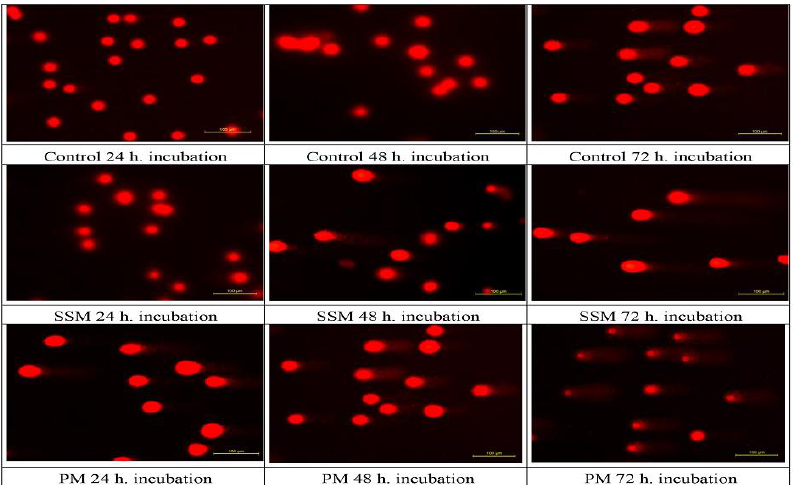
Figure 5. Genotoxic effect of 4 mg/mL of SSM and 1 mg/mL of PM on L-929 cells compared to non-treated ones after 24, 48 and 72 h incubation. Comet formation pattern showed that SSM induces a much lower DNA damage on these cells than PM after 48 and 72 h of incubation. Toxics 2018 , 6 , 7